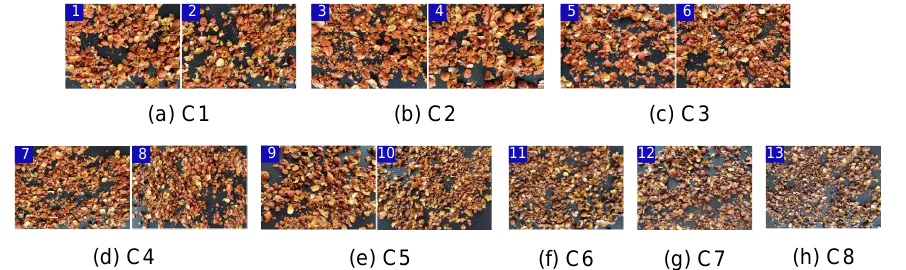
Figure 2. Images of GFP under eight different stir-frying stages. Note: C1 shows the process after 1 min, C2 shows the process after 2 min, and so